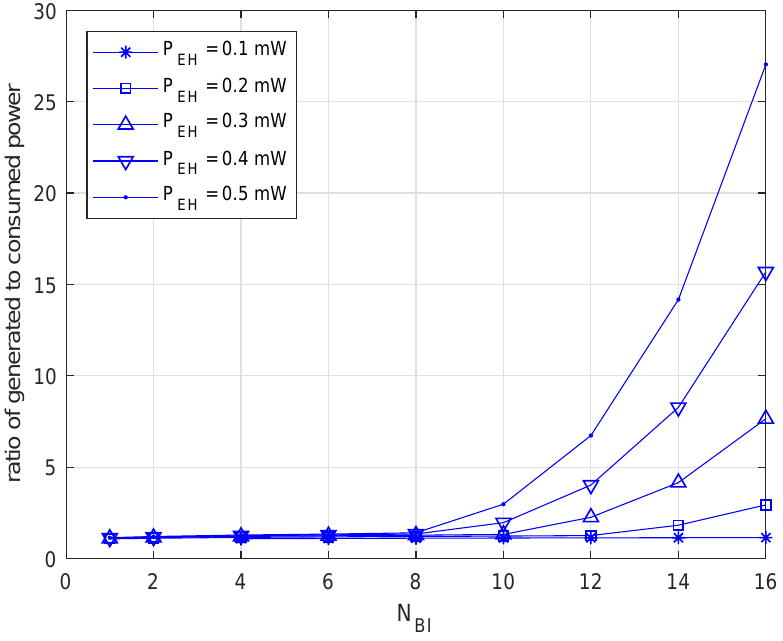
Figure 10. Ratio of excessive